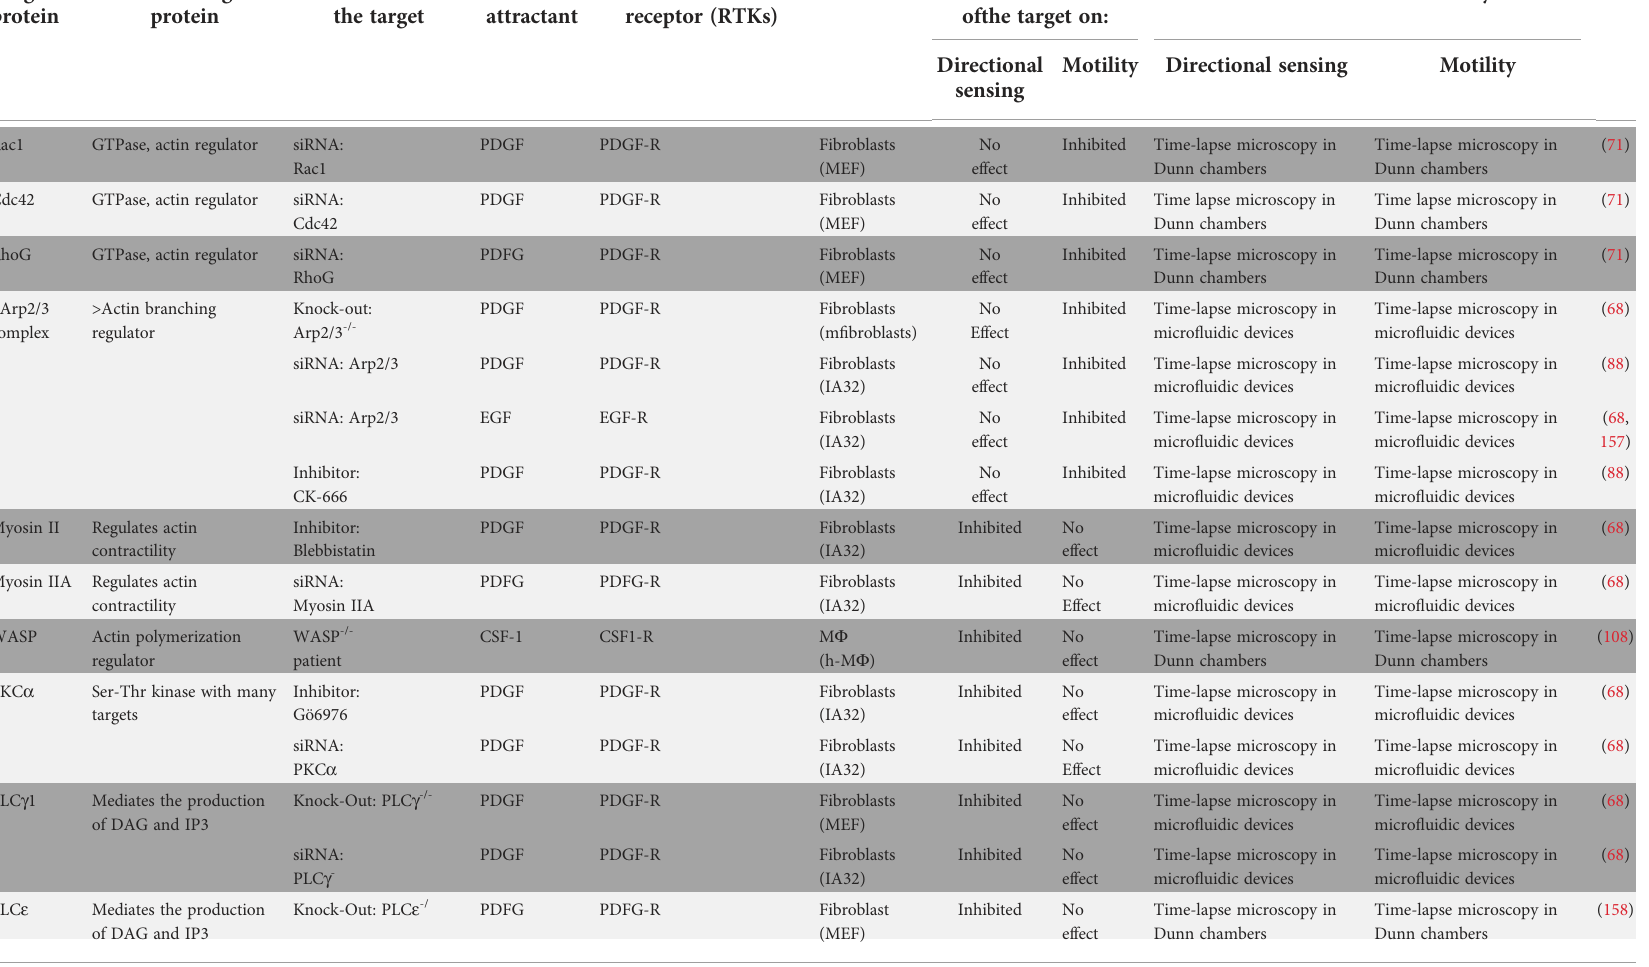
TABLE 4 Independent regulation of directional sensing and motility downstream of the Receptor Tyrosine kinase family of chemoattractant